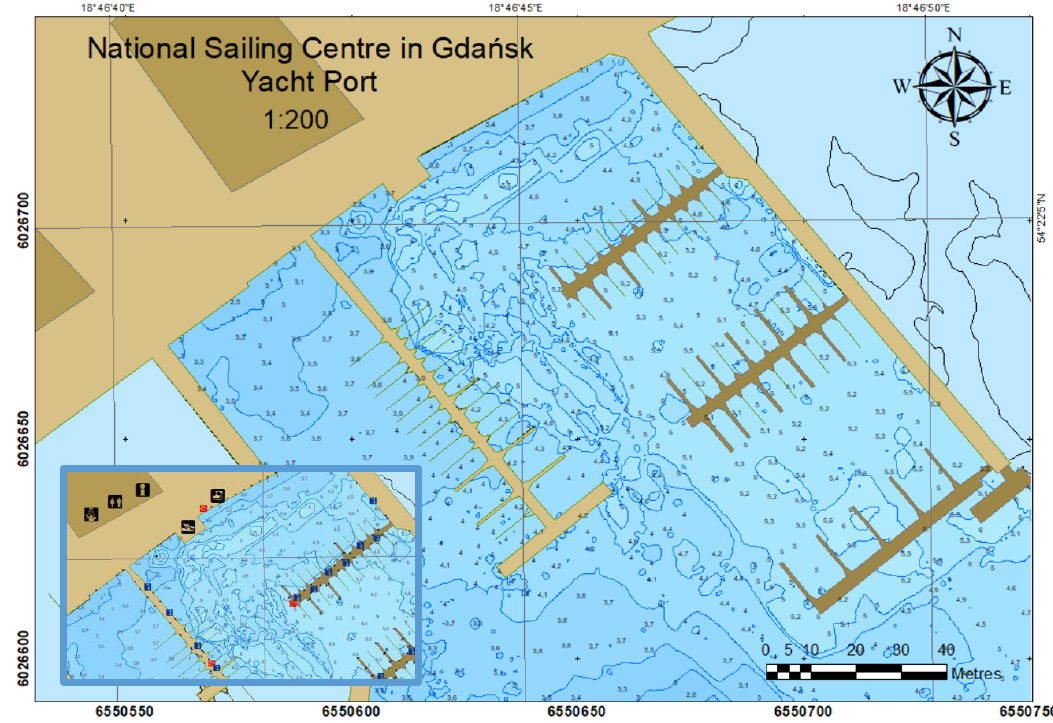
Figure 10. Figure 10. A bathymetric chart as a 2D model in basic (main view) and extended (small view) presentations.